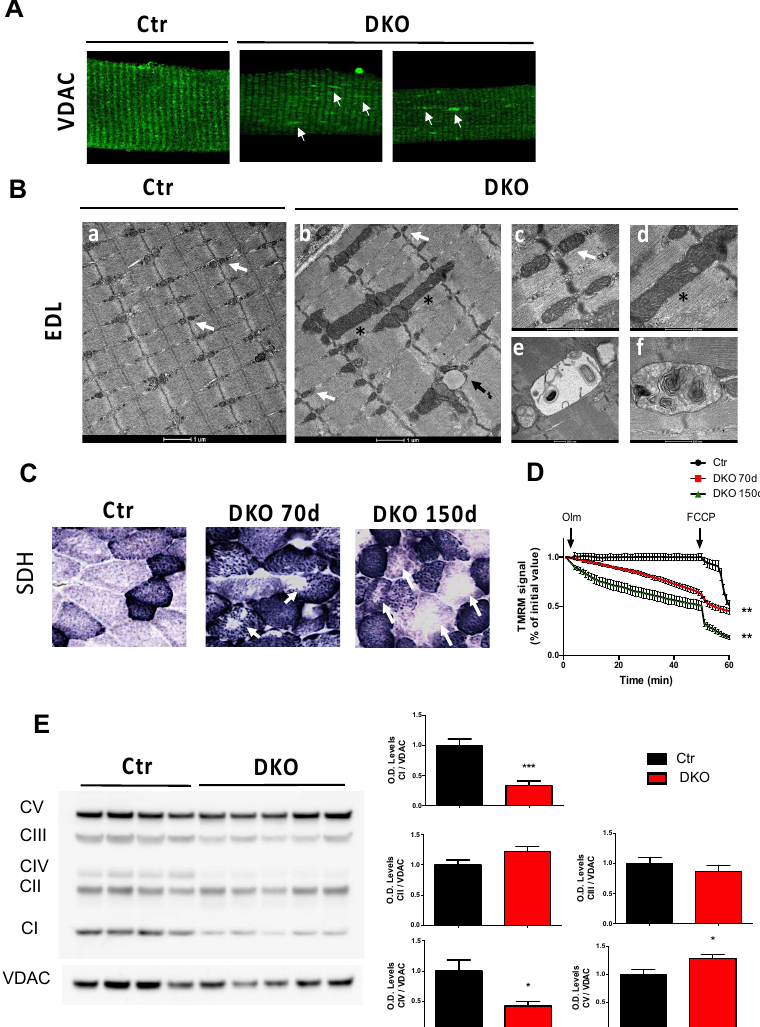
Figure 2. Double-knockout (DKO) muscles have alterations in mitochondrial morphology and function. ( A ) Confocal microscopy of single isolated flexor digitorum brevis (FDB) fibers immunostained for Voltage-Dependent Anion Channel (VDAC). Arrows show longitudinally elongated mitochondrial structures in DKO muscles. ( B ) Representative electron micrographs of EDL muscles of controls and DKO mice. Control mitochondria (pointed by white arrows in insets a and c) were placed in proximity of Z lines and usually exhibited an electron-dense matrix. DKO muscles displayed a mixture population of normal mitochondria (indicated by white arrows in inset b), larger longitudinally oriented mitochondria (indicated by asterisks in insets b and d), and mitochondria with disrupted (inset e) or onion-like cristae (inset f). ( C ) Succinate dehydrogenase SDH staining of GNM sections indicating the presence of bigger mitochondria in some fibers from 70 days and 150 days DKO mice. White arrows indicate central fiber areas depleted of mitochondria. ( D ) Absence of Drp1 and Opa1 induced mitochondrial depolarization in FDB muscle fibers from DKO 70 days and 150 days mice. Isolated adult FDB fibers were loaded with TMRM. Oligomycin (Olm) and FCCP were added at the indicated time points. ( E ) Immunoblot and densitometric analysis of mitochondria OXPHOS complexes levels. complex I (CI) and complex IV (CIV) were significantly decreased in GNM muscles from adult DKO mice. Data are shown as mean ± SEM. Two-tailed unpaired Student’s t -test was used. Statistical significance: * p < 0.05, ** p < 0.01**, *** p < 0.001, compared to control.